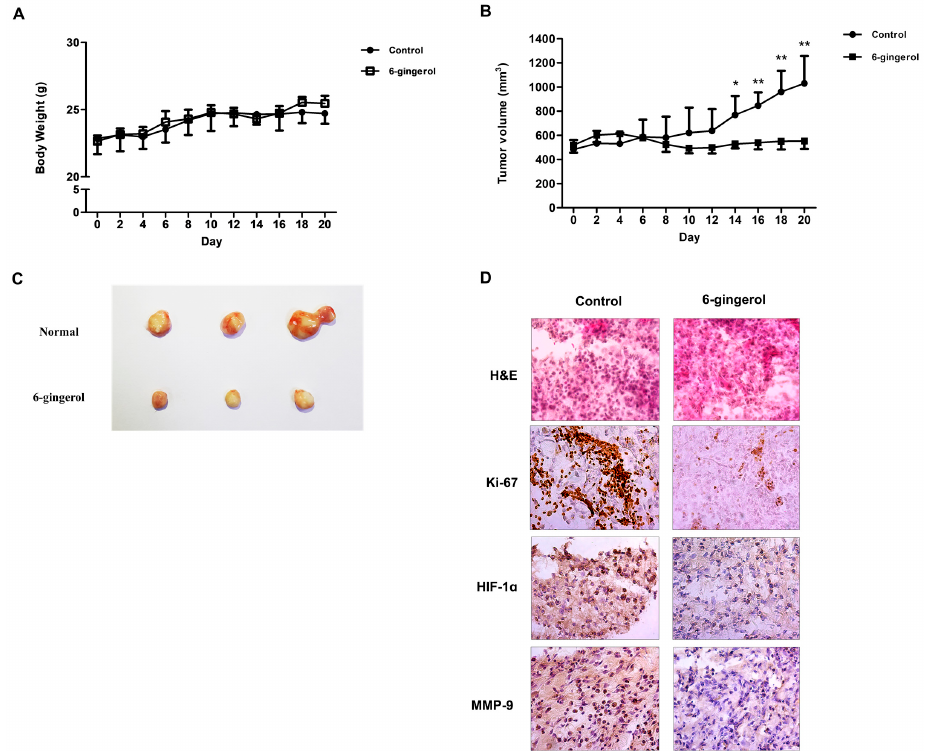
Figure 7 . 6-Gingerol suppressed LC cell growth in mice. BALB/c nude mice were subcutaneously injected with H460 cells. (A) The tumor growth rate and (B) mouse body weight are shown. ( C ) The tumor images; ( D ) IHC staining of Ki-67, MMP-9, and HIF-1 α was carried out. The data are pre- sented as the mean ± SEM. * p < 0.05, ** p < 0.01, and compared to untreated cells.